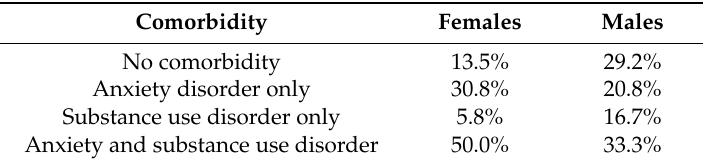
Table 4. Proportion of suicide attempts by comorbidity.